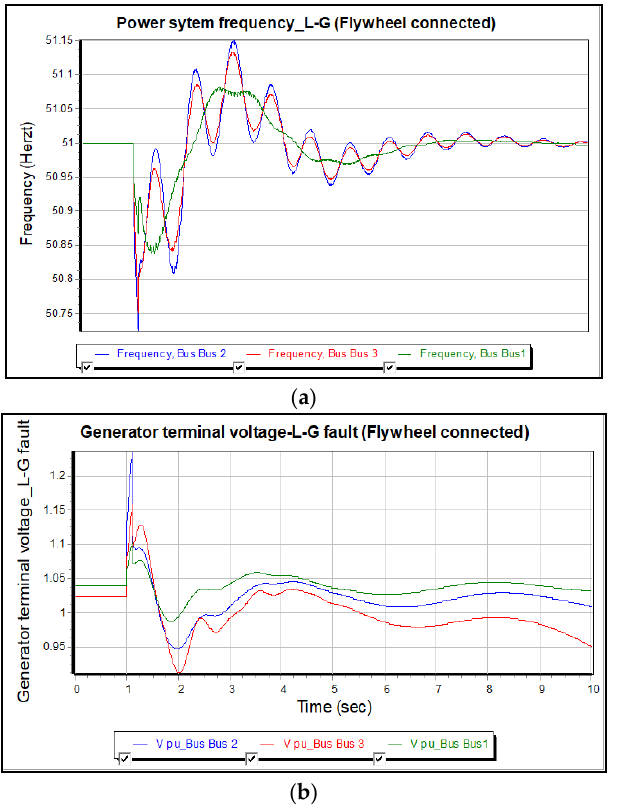
Figure 10. Simulation of asymmetrical fault (L-G fault at 50% PV Penetration): ( a ) response power system frequency; ( b ) voltage recovery of power system after line-to-ground fault.